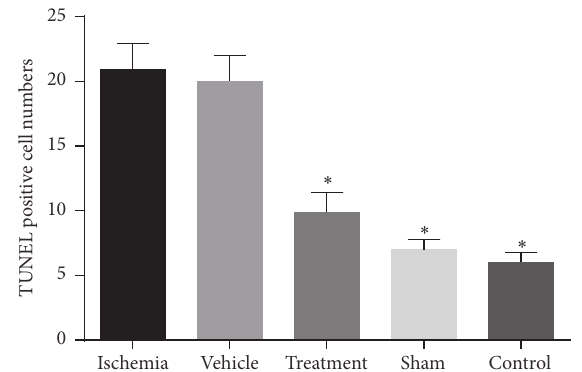
Figure 4: The mean number of TUNEL positive cells in the study groups. The ischemia group had the greatest number of TUNEL positive cells. There was a significant difference (shown with ∗ ) in the numbers of apoptotic cells between the ischemia and control groups ( 𝑃 = 0.000